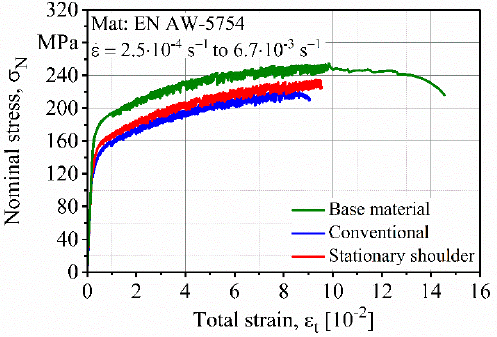
Figure 6. Quasi-static tensile test results of the base material, conventional and stationary shoulder FSW specimens.